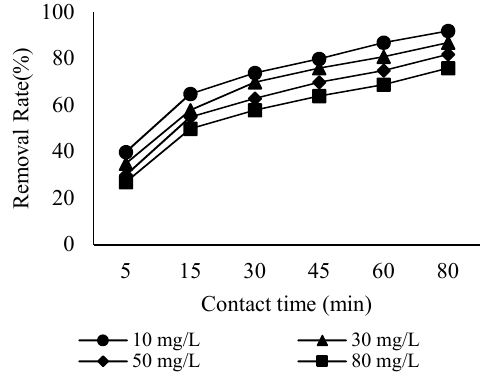
Fig. 6. The effects of lead concentration on the adsorption by MBAS (pH =11, 318 ºK, and adsorbent conc.= 0.5